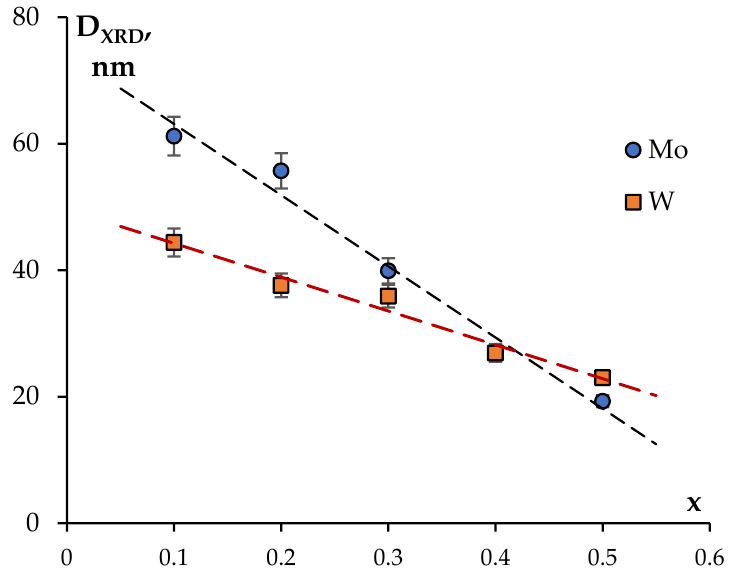
Figure 8. Dependencies of the CSR sizes (D XRD ) on the Mo and W contents in the Na 1-x Zr 2 (PO 4 ) 3- x (XO 4 ) x powders.